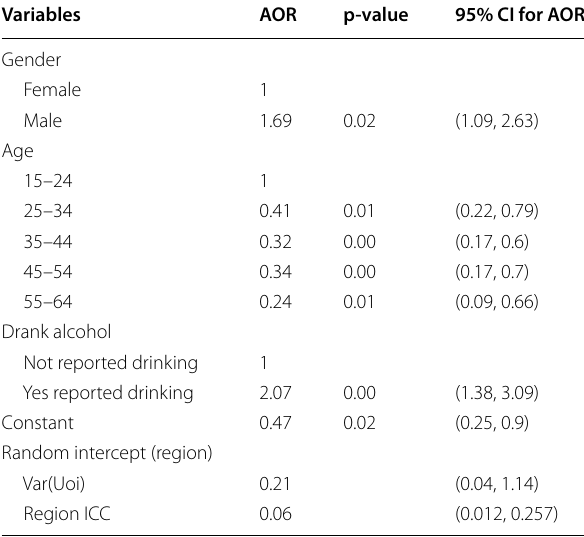
Table 5 AOR and 95% CI for AOR of the multilevel mixed-effect logistic regression for the associated factors for lately tested HIV among PLHIV in urban of Ethiopia (2017/18)